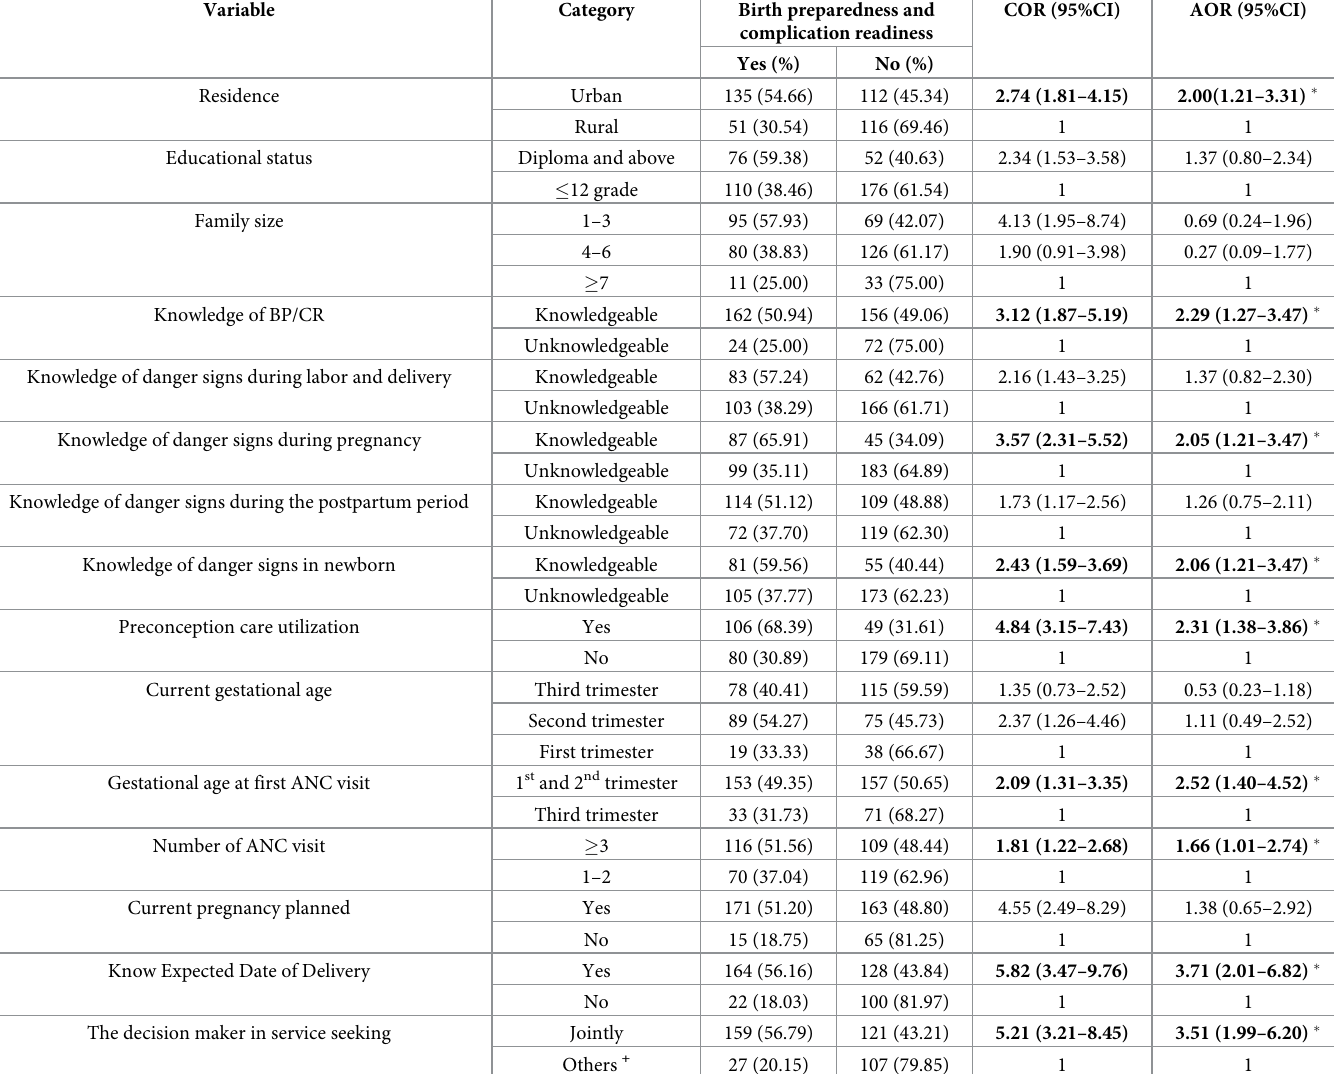
Table 5. Factors associated with BP/CR among pregnant women attending antenatal care service at North Shewa zone public hospitals, Oromia region, central Ethiopia, 2021 (n =